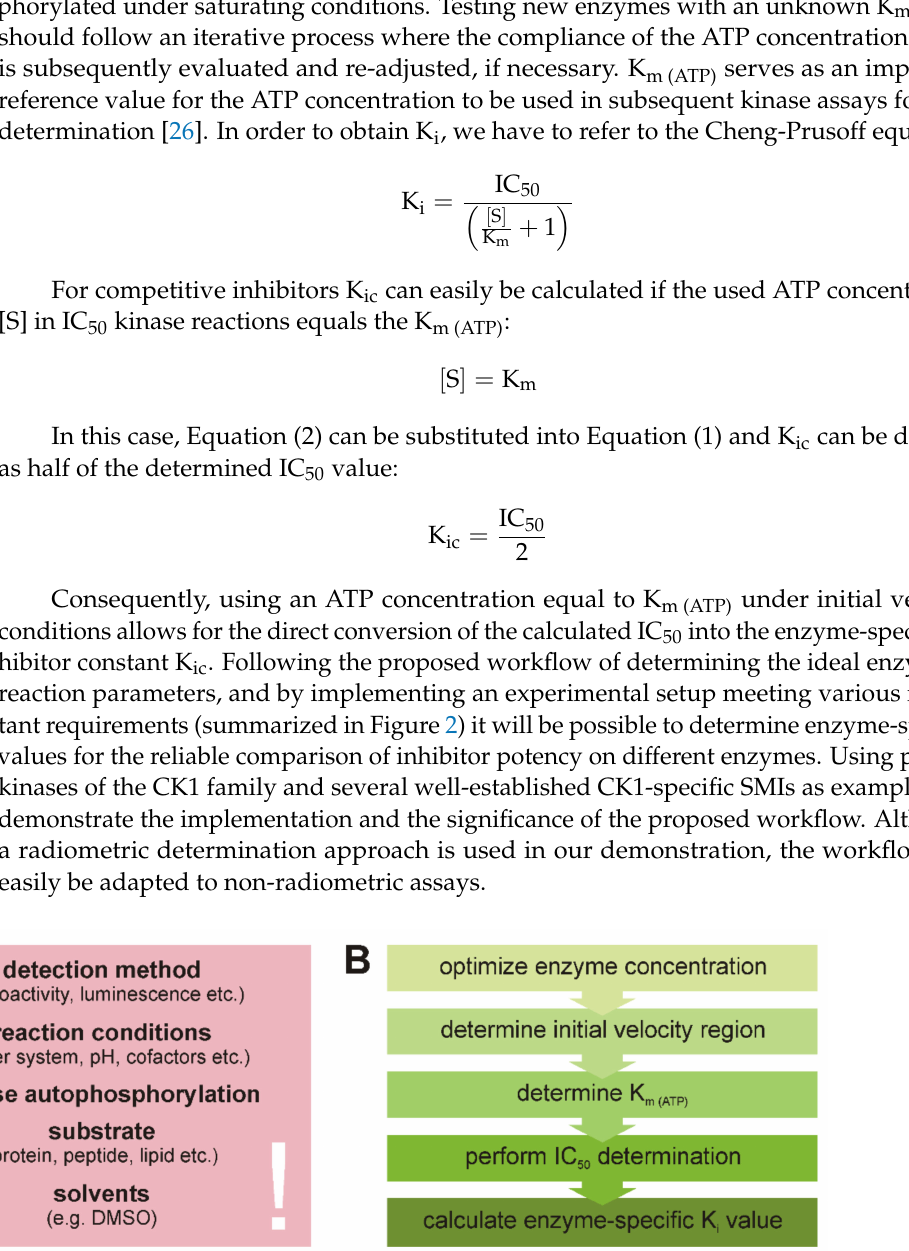
Figure 2. Considerations and suggested workflow for in vitro kinase inhibitor characterization. ( A ) Apart from basic considerations concerning the detection method to be used and the reaction conditions, also enzyme- and substrate-specific characteristics need to be taken into account. ( B ) The suggested workflow consists of five steps resulting in generation of major parameters essential to calculate K i values, which can be easily used to compare inhibitory effects for various SMIs and different